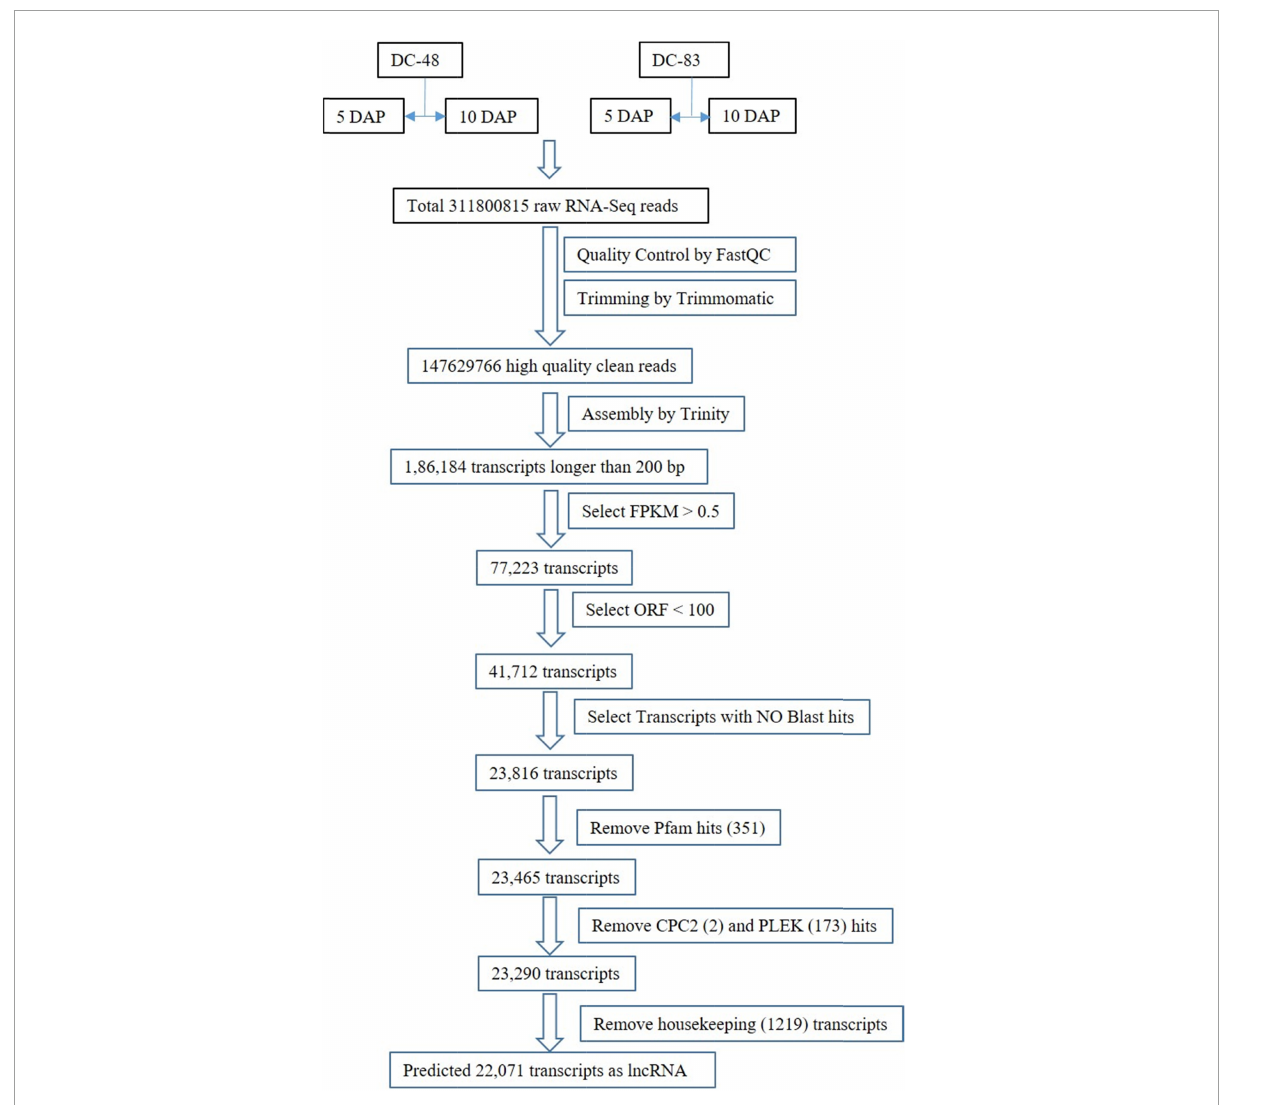
FIGURE1 Work flow for identification of genome wide lncRNA from Cucumber